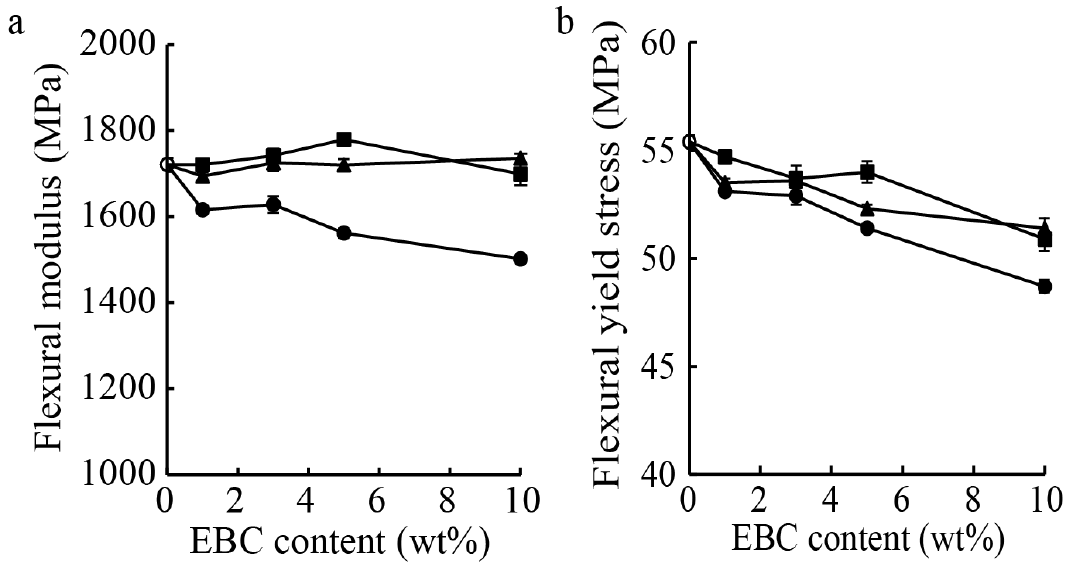
Figure 3. ( a ) Flexural moduli and ( b ) yield stresses of neat polypropylene (PP) (○), the PP/ethylene-butene copolymer (EBC) blends (●), and the wood flour (■) and lignocellulose nanofiber (LCNF) (▲)